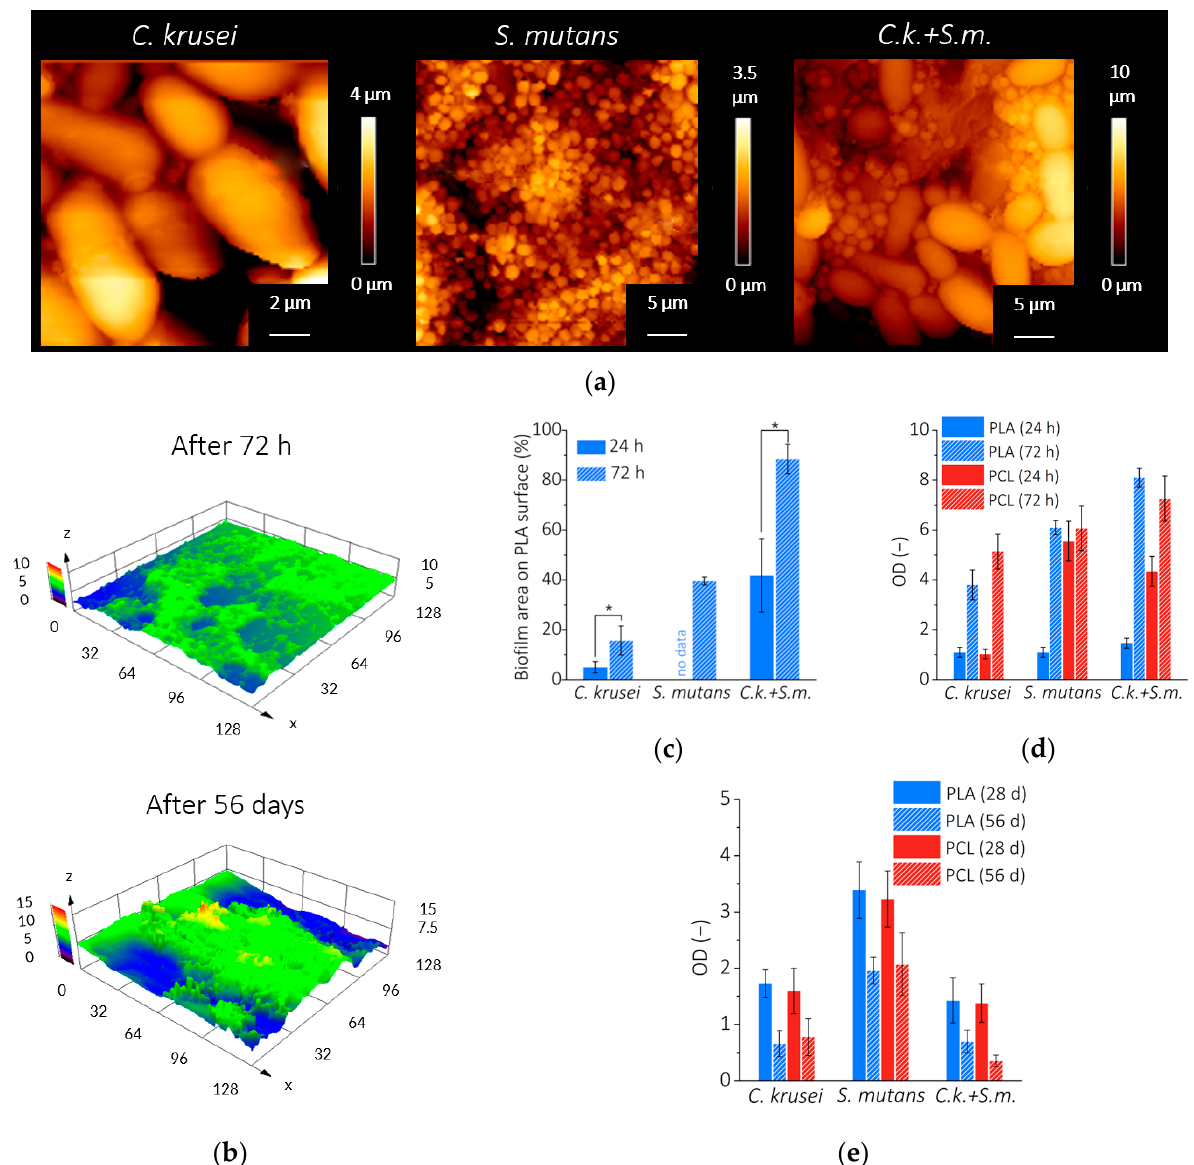
Figure 1. Biofilm ( C. krusei , S. mutans , or C. krusei + S. mutans ) on the surface of the tested polymers: ( a ) AFM topography of individual types of biofilm on the surface of PLA after 72 h; ( b ) CLSM topography of the C. krusei + S. mutans biofilm on the PLA surface after 72 h and 56 days; ( c ) biofilm development on the PLA surface during the first 72 h (based on CLSM); ( d ) biofilm development on the surface of PLA or PCL during the first 72 h (based on the optical density of the biofilm mass stained with CV); ( e ) biofilm development on the surface of PLA or PCL for 56 days (as measured by the optical density of the biofilm mass stained with CV). Results mean ± SD ( n = 3). (*) p < 0.05.